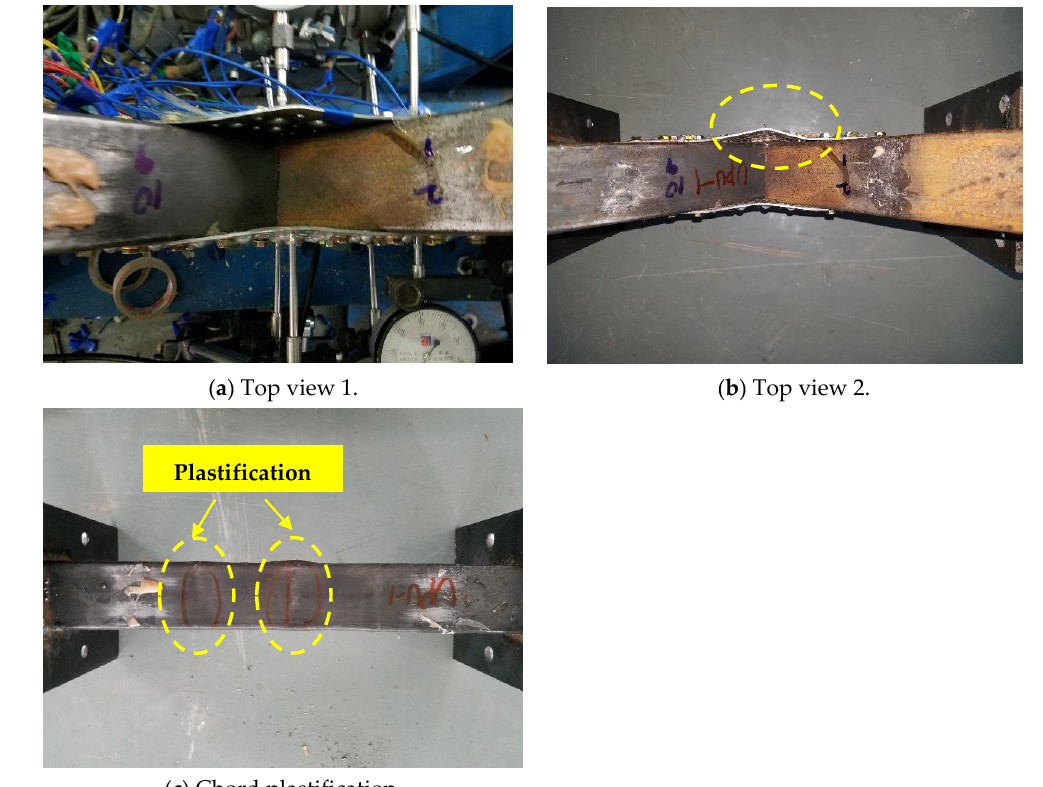
Figure 12. Deformation of the specimen UPL-1.